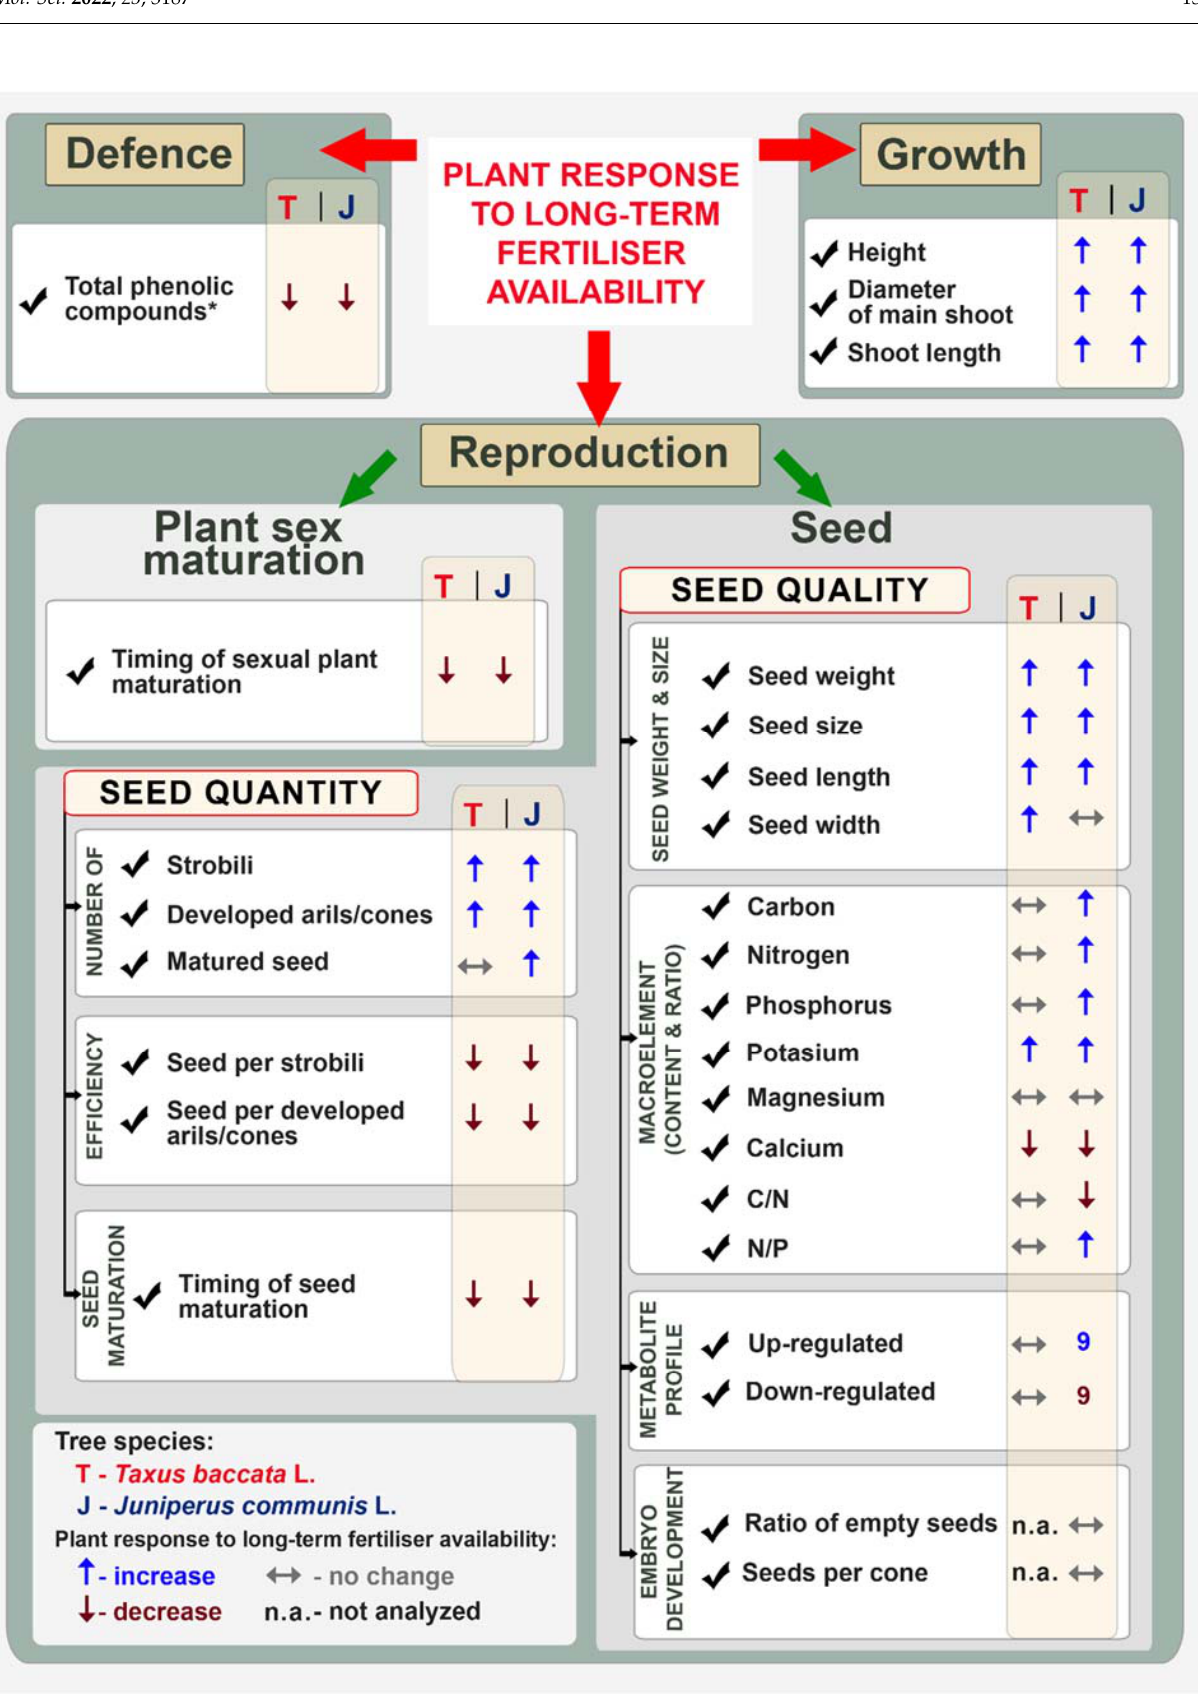
Figure 8. Plant response to long ‐ term fertiliser availability. * Data summarised after [31,41]. Seeds are “genetic time capsules” provided by the mother plant and assigned to en ‐ sure plant fitness. Upon fertilisation, seed development and maturation are fundamental processes controlled by the genetic make ‐ up of the mother plant, but also influenced by the environment it experiences. Therefore, the main female plant function is to produce